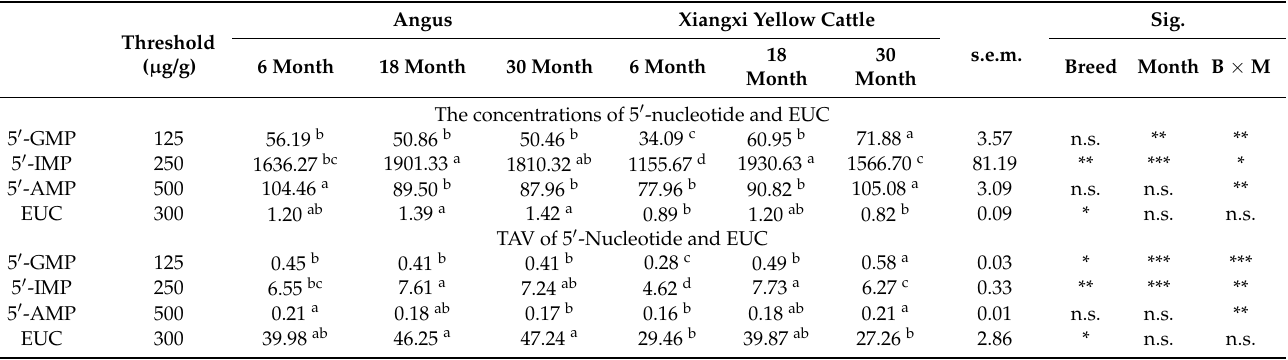
Table 2. The concentrations of 5 (cid:48) -nucleotides ( µ g/g), the calculated EUC (g MSG/100 g) and TAV of LT muscle from Angus and Xiangxi yellow